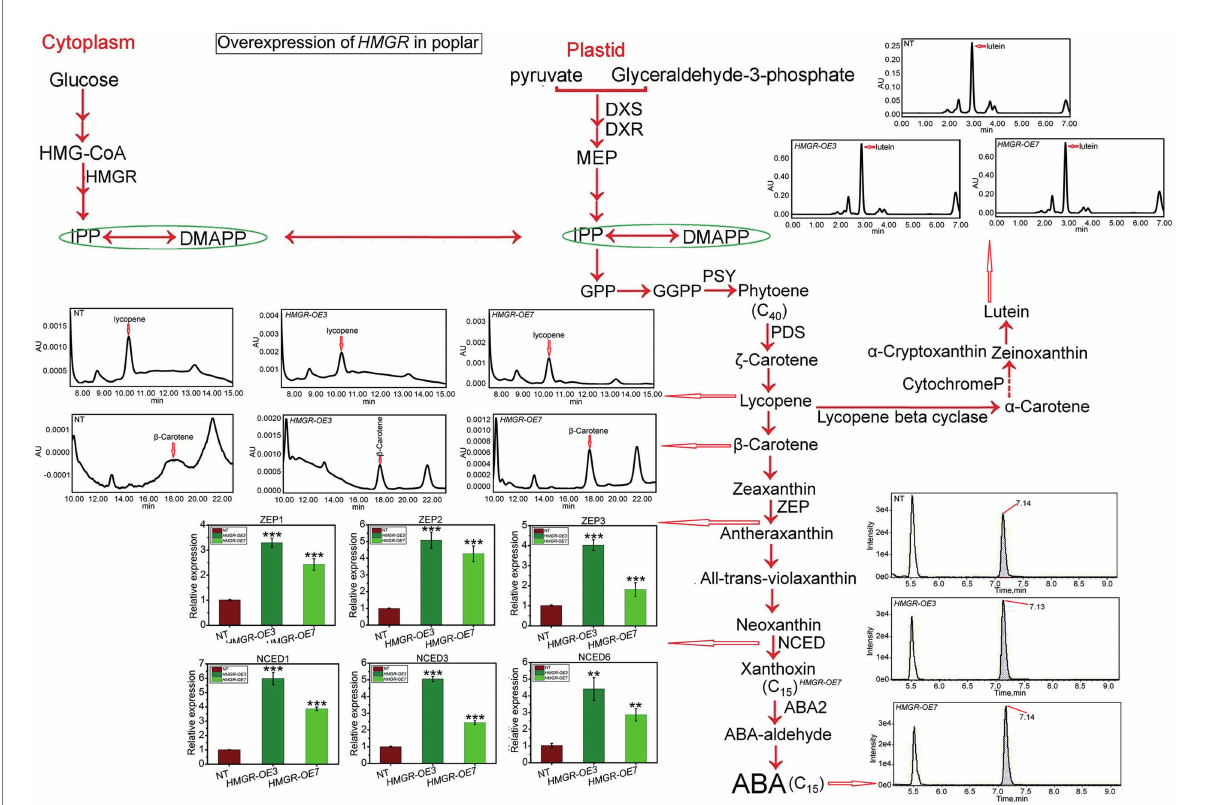
FIGURE 2 Evaluation of the effect of the overexpression of PtHMGR on isoprenoid production and ABA. The qRT-PCR analyses of the expression levels of ABA synthesis-related genes and HPLC-MS/MS analyses of the contents of ABA, β -carotene, lycopene, and lutein in PtHMGR -OEs. The expression levels of the ABA synthesis-related ZEP and NCED genes family are shown. Bars represent mean ± SD ( n = 3); Stars reveal significant differences, ** p < 0.01, *** p < 0.001; Experiments were performed in